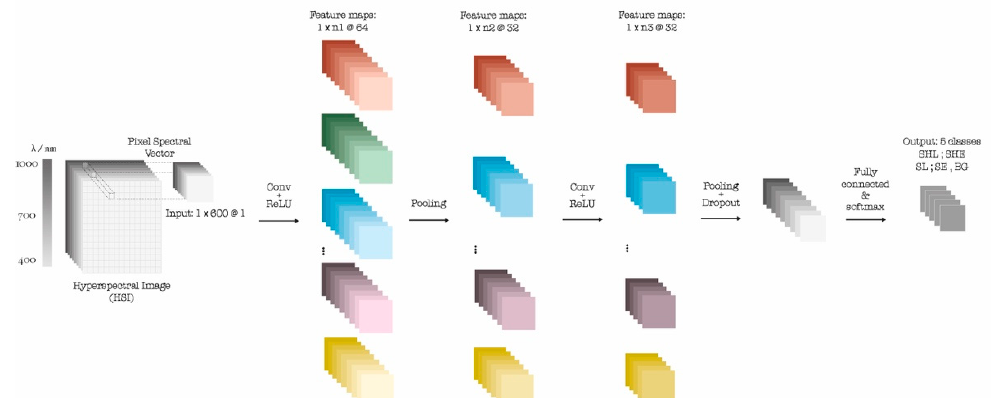
Figure 3. Schematic representation of the proposed 1D-CNN framework with the full spectrum bands as inputs.